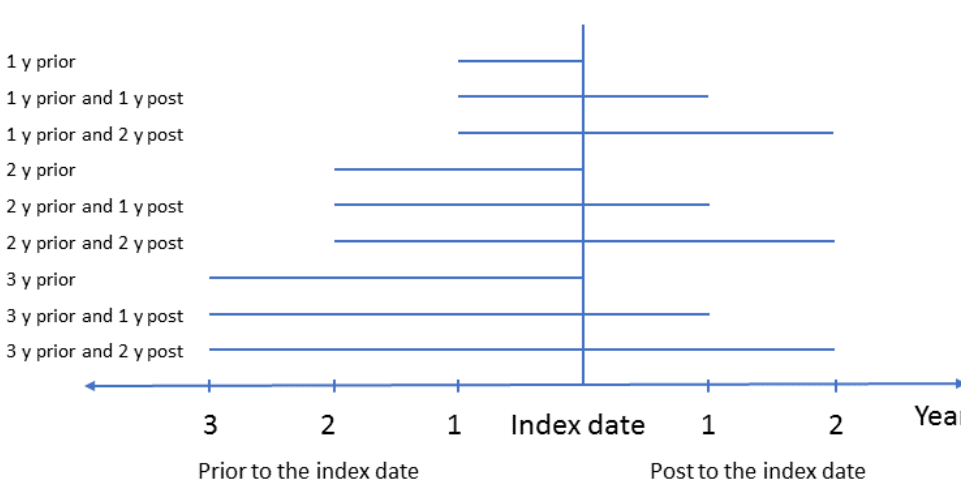
Figure 1: Nine time points tested to identify the sleep disorder cases using ICD